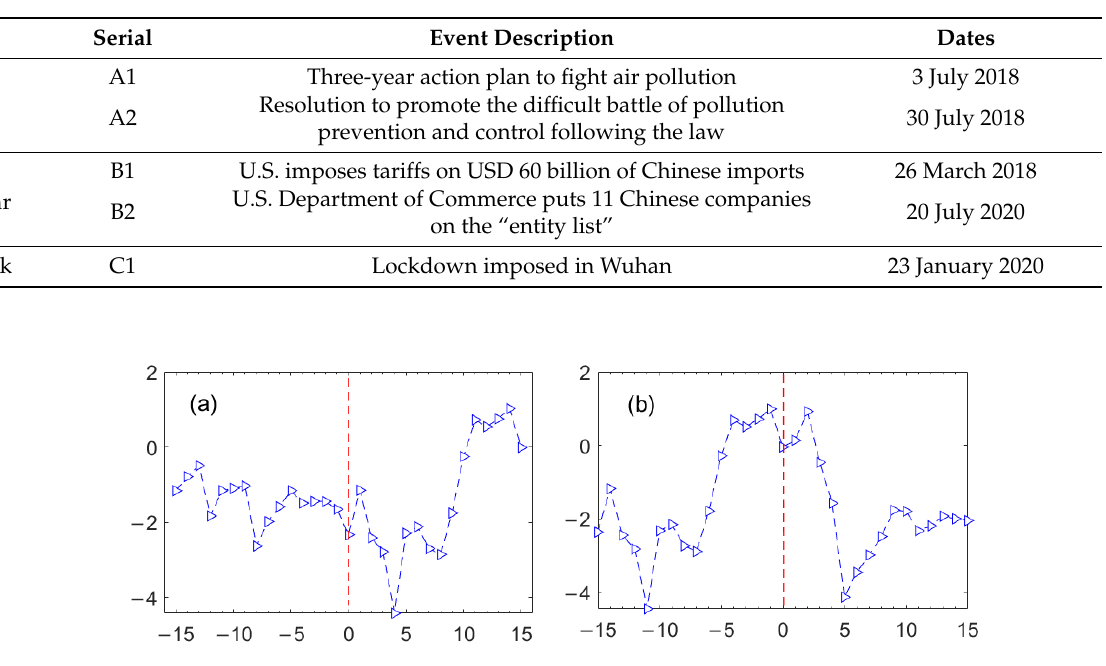
Figure 4. Strike of government policies on the outlier of net spillover effect: ( a , b ) show the outlier of the net spillover index between the carbon and overall stock markets after the shocks of government policies A1 and A2.